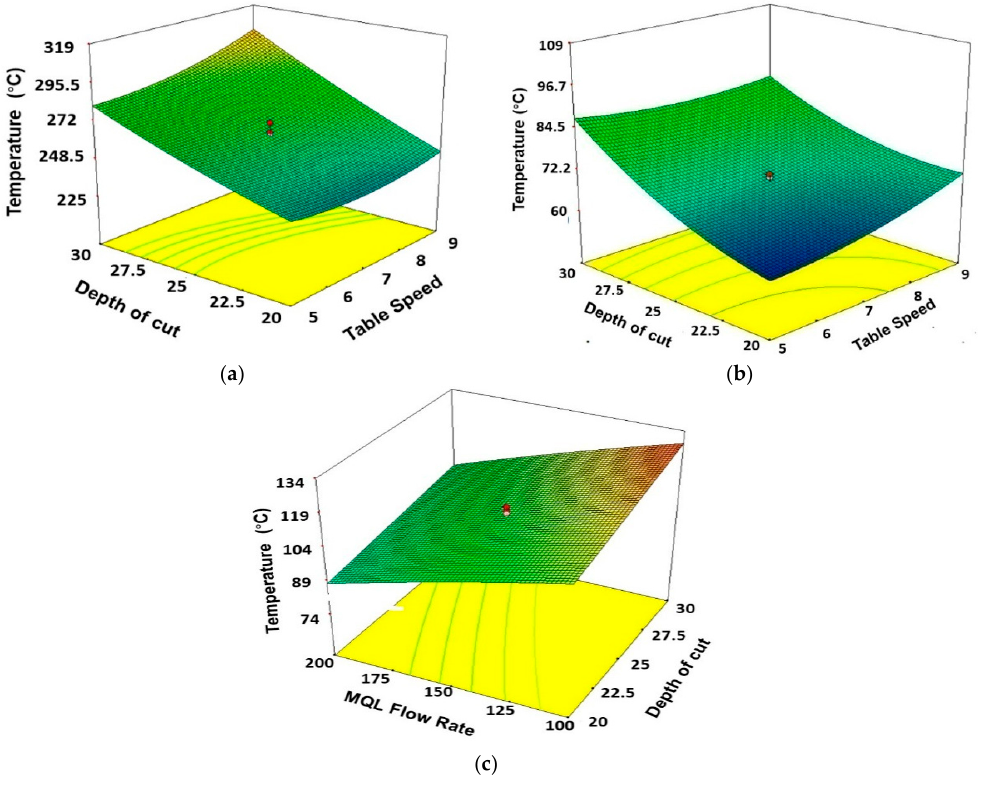
Figure 6. Surface plots showing the effects of depth of cut and table speed on temperature for ( a ) Dry, ( b ) Wet, ( c ) and MQL conditions. Units of table speed, depth of cut, and MQL flow rate are ‘m/min’, ‘µm’, and ‘mL/h’, respectively.